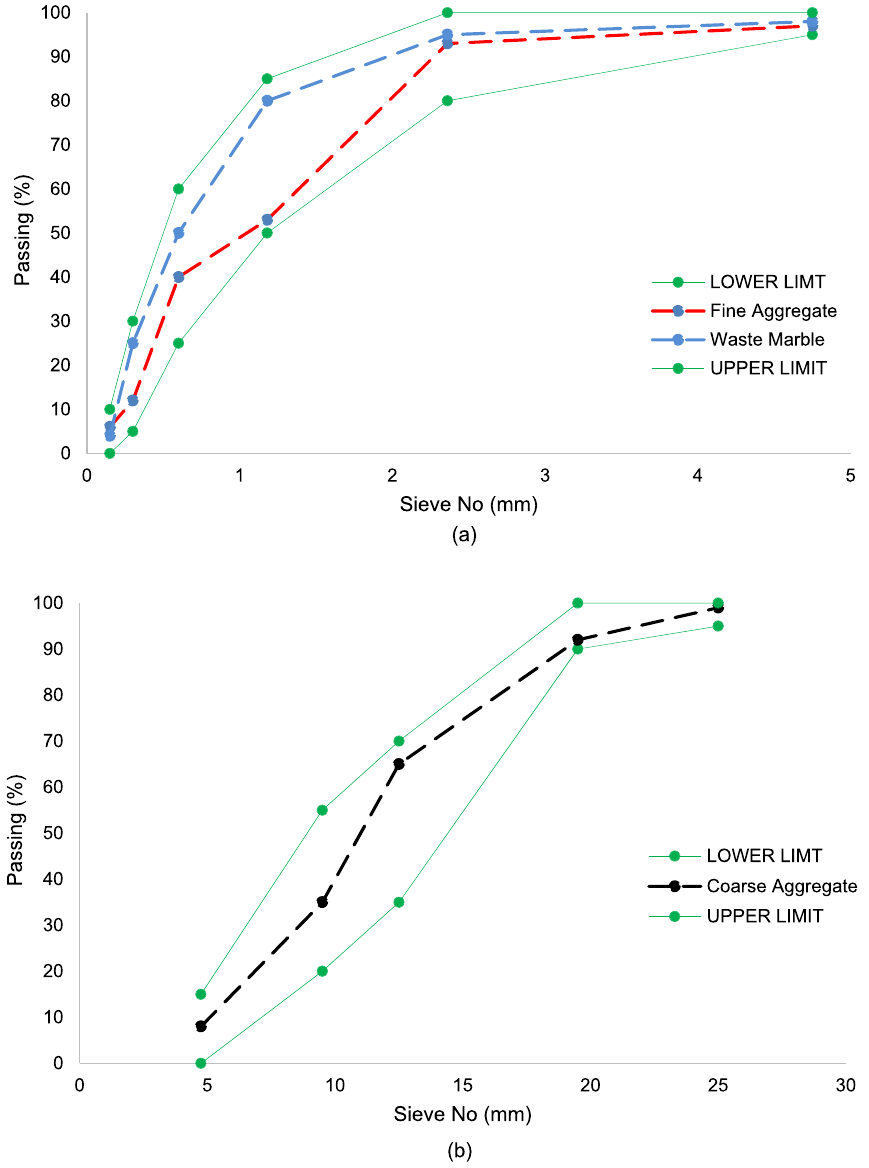
Figure 2. ( a ) Gradation curve of sand versus marble and ( b ) Gradation curve of coarse aggregate.